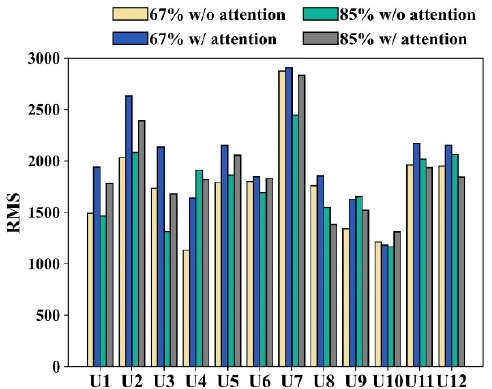
Figure 10. The results of muscle contraction of each subject were based on different attentional focus conditions and different lifting weights of the 1RMs.